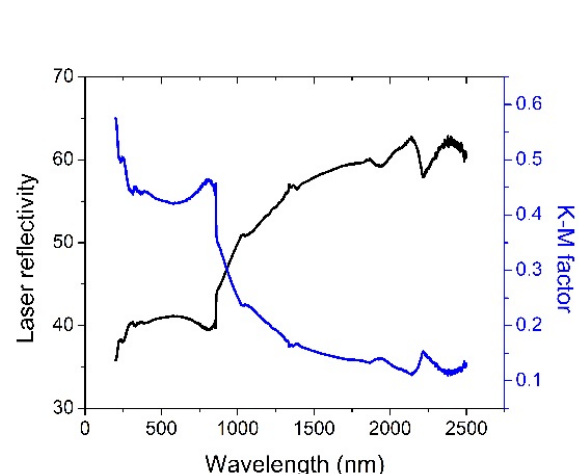
Figure 5. The laser reflectivity and K ‐ M absorption factor of the atomized TiB 2 ‐ reinforced Al–3.8Cu–1.3Mg composite